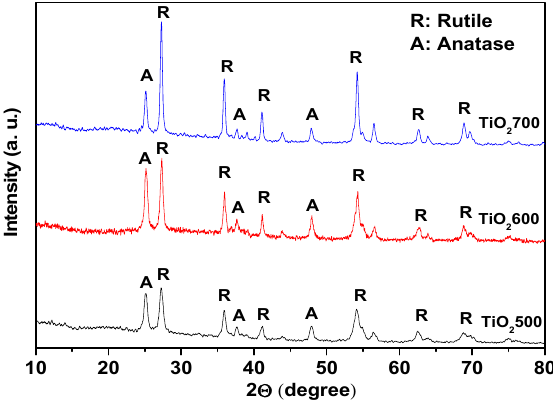
Figure 4. X-ray patterns of fibrous TiO 2 . Table 1. Phase composition and average crystallite size of the fibrous TiO 2 . Sample